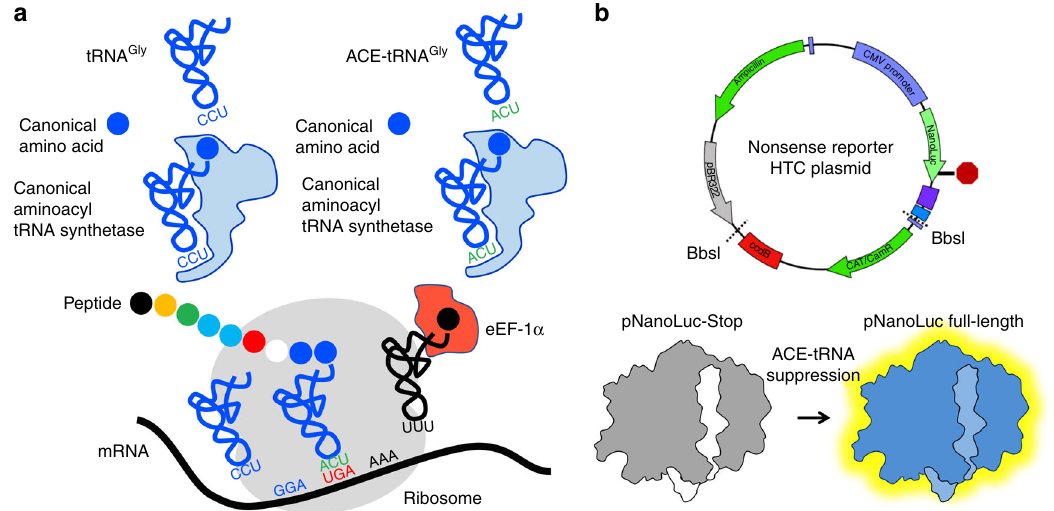
Fig. 1 A nonsense mutation suppression screen to identify candidate anticodon edited tRNAs (ACE-tRNAs). a Schematic illustrates requisite interactions of ACE-tRNAs with translational machinery. Following delivery, ACE-tRNAs are recognized by an endogenous aminoacyl-tRNA synthetase (blue shape) and charged (aminoacylated) with their cognate amino acid (blue circle). The aminoacylated ACE-tRNA is recognized by the endogenous elongation factor 1-alpha (red shape), which protects the ACE-tRNA from being de-acylated and delivers the aminoacyl ACE-tRNA to the ribosome (light gray shape) for suppression of a premature termination codon, in this instance UGA. b Individual ACE-tRNAs were cloned into the high throughput cloning nonsense Reporter plasmid using Golden Gate paired with CcdB negative selection. The all-in-one plasmid contains the NLuc luciferase reporter with either a UGA, UAG, or UAA PTC at p.162 between the enzymatic large bit and requisite C-terminal small